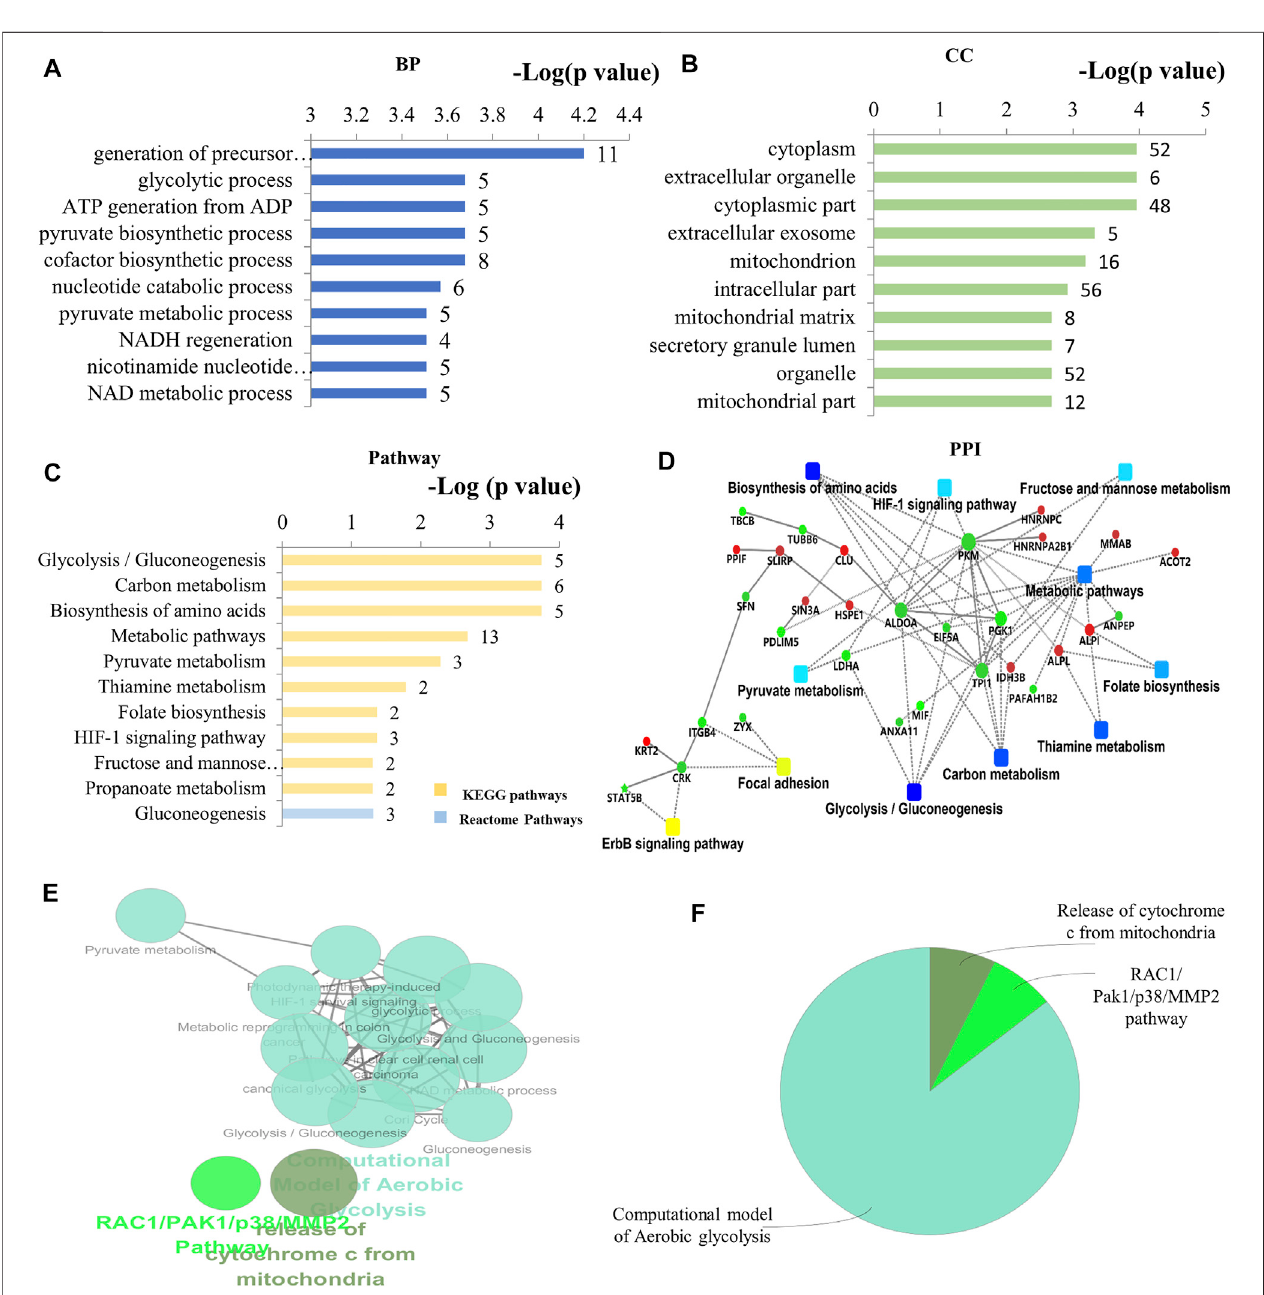
FIGURE 3 | Bioinformatics analysis of the differentially expressed proteins in As/Ctrl group. (A) The top 10 ranking of BP associated with differentially expressed proteins. (B) Thetop10rankingofCCassociatedwithdifferentiallyexpressedproteins. (C) Thesigni fi cantlyenrichedpathwayslinkedtodifferentiallyexpressedproteins. (D) PPI network linked to the differentially expressed proteins in As/Ctrl group. Red: the expression of these proteins was up-regulated. Green: the expression of these proteins was down-regulated. (E) Functional interaction network analysis was performed by using ClueGO cytoscape plugin. (F) Overview the speci fi c cluster. (A – C) Number of proteins associated with each category for gene-enrichment analysis is shown on the right of each term bar.